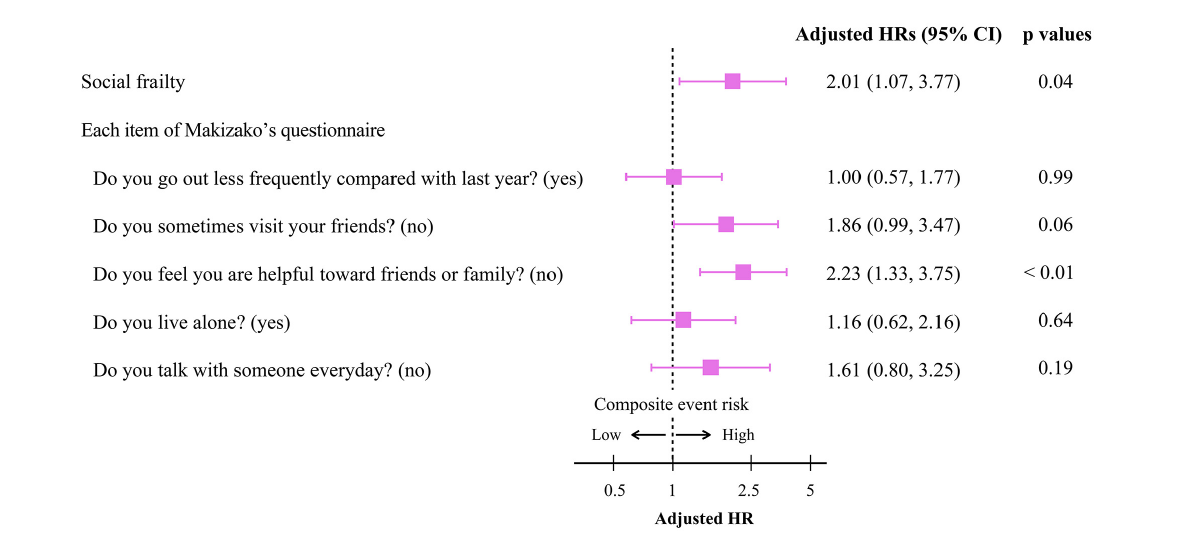
FIGURE4 Cox proportional hazard analyses for the composite event according to the presence/absence of social frailty and the negative/positive response to each Makizako’s 5 questions in older HF patients. The model was adjusted for age, sex, prior hospital admission due to HF, HFrEF, Log NT-proBNP, eGFRcys, and Charlson comorbidity index. HR, hazard ratio; CI, confidence interval; HFrEF, heart failure with reduced ejection fraction; Log NT-proBNP, logarithmic N-terminal pro B-type natriuretic peptide; eGFRcys, cystatin C-based estimated glomerular filtration rate.